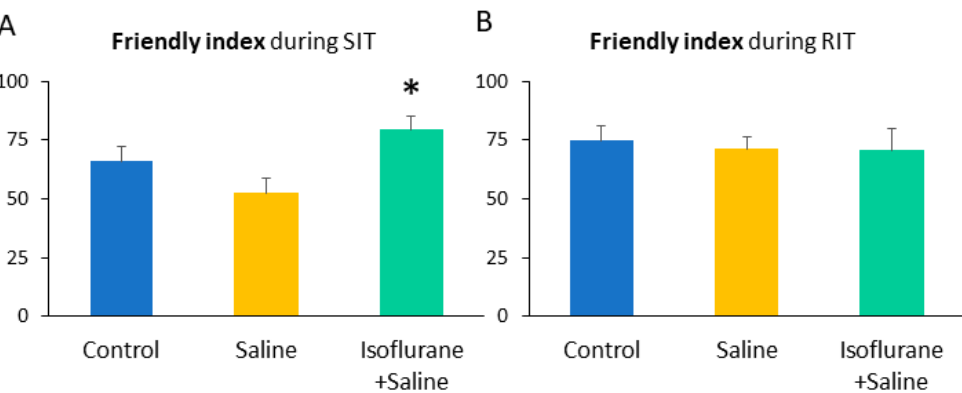
Figure 4. Friendly index during social interaction (SIT; A ) and resident–intruder (RIT; B ) tests. During SIT, the isoflurane+saline pre-treatment increased friendly social encounters among the social interactions compared to saline-treated mice ( A ). However, there was no difference between the groups during the RIT test (n = 9–10/group). * p < 0.05 vs. saline-treated group.